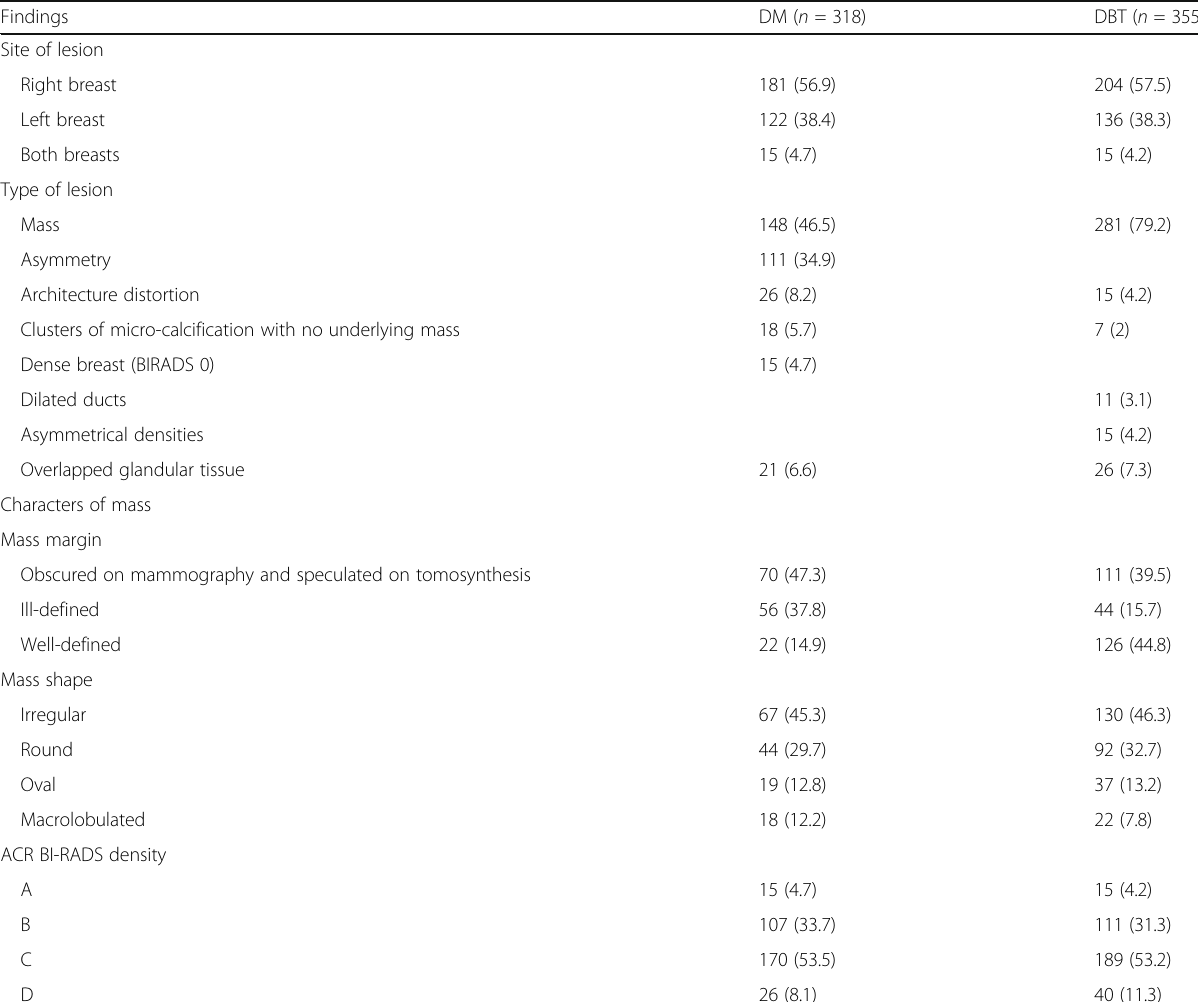
Table 2 DM and DBT findings